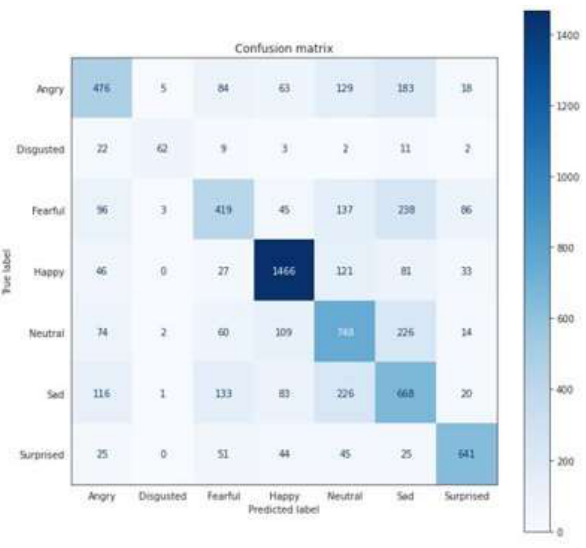
Figure 10 . Confusion matrix on testing